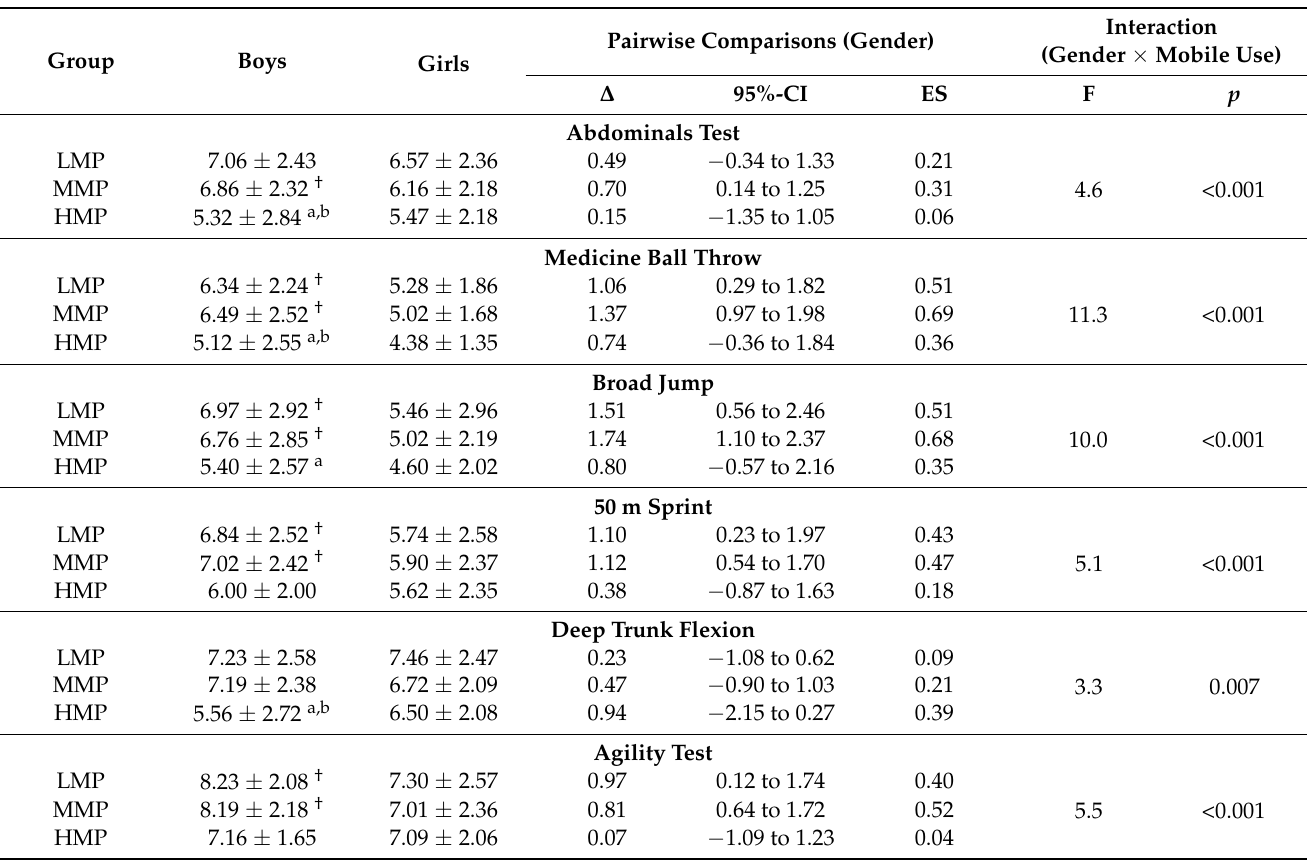
Table 1. Results of physical